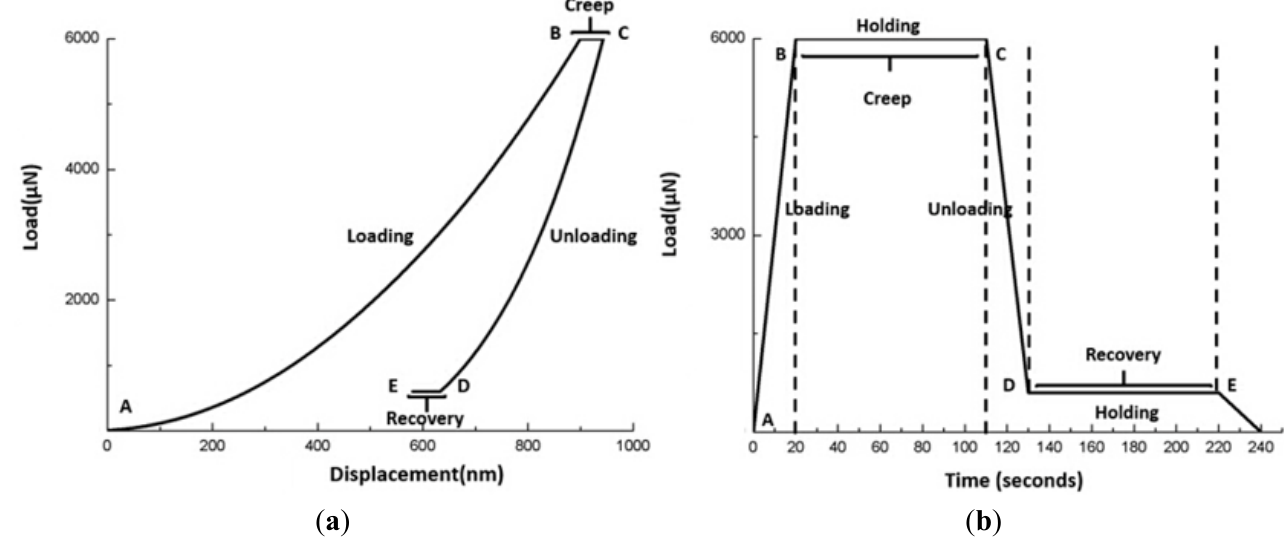
Figure 2. Schematic of nanoindentation creep and recovery test. ( a ) load-displacement curve. ( b ) load-time